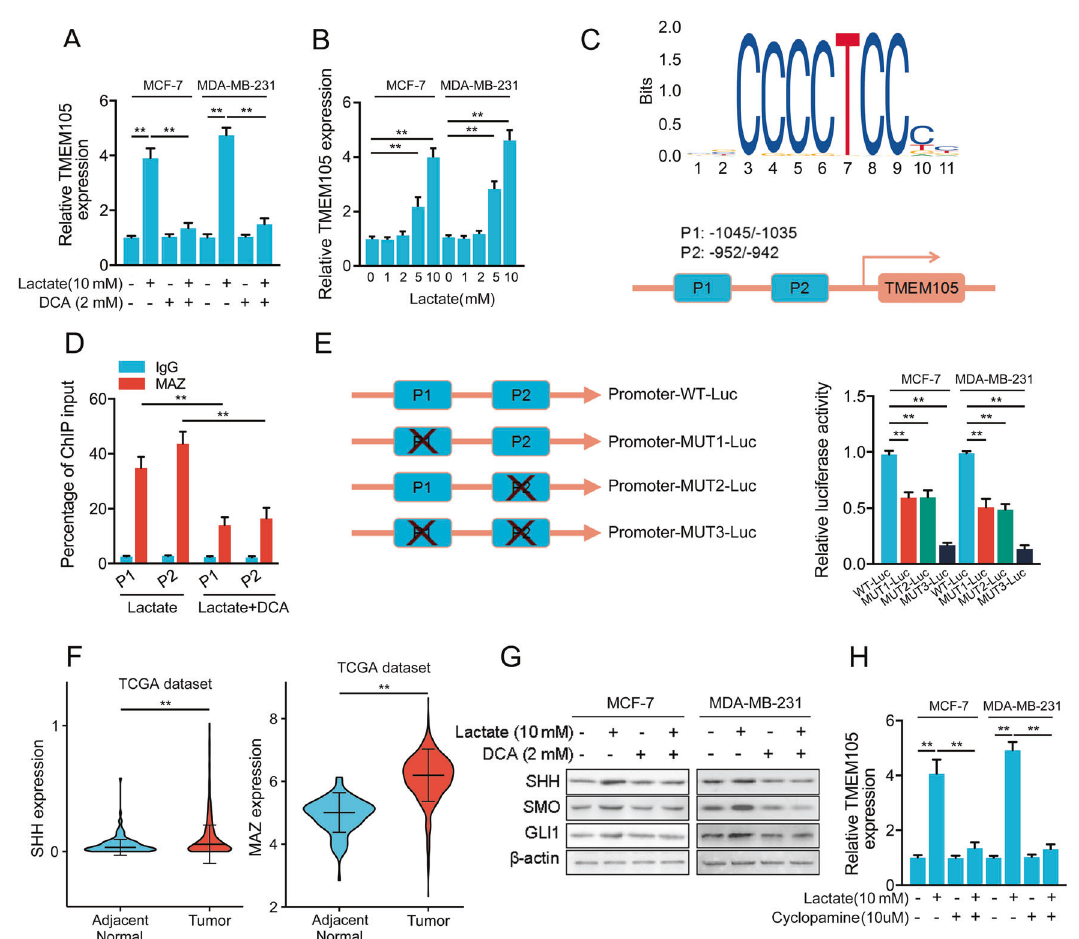
Fig. 8 Lactate promotes TMEM105 expression by SHH-MAZ signaling pathway. A The lactate secretion inhibitor DCA (2 mM) downregulated TMEM105 expression in MCF-7 and MDA-MB-231 cells treated with lactate (10 mM) for 24 h. B TMEM105 expression was determined by qRT-PCR in MCF-7 and MDA-MB-231 cells treated with different concentrations of lactate for 24 h. C The schematic images of the MAZ binding motif and the potential binding sites of MAZ in the TMEM105 promoter. D ChIP assay was used to detect the roles of MAZ binding sites on the TMEM105 promoter region. E TMEM105 reporter vectors with truncated mutants in the promoter region at site P1, site P2, or both sites were transfected into MCF-7 or MDA-MB-231 cells treated with lactate (10 mM), and luciferase activity was detected. F SHH and MAZ expression in adjacent normal and breast cancer tissues in the TCGA dataset. G Expression of SHH, SMO, and GLI1 was examined in breast cancer cells using Western blot. H Effects of cyclopamine (10 μ M) on TMEM105 expression in breast cancer cells treated with lactate (10 mM). ** p <